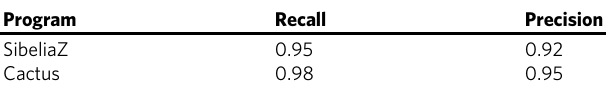
Table 4 Recall and precision of the alignments computed by Cactus and SibeliaZ on the “ primates ” dataset from the